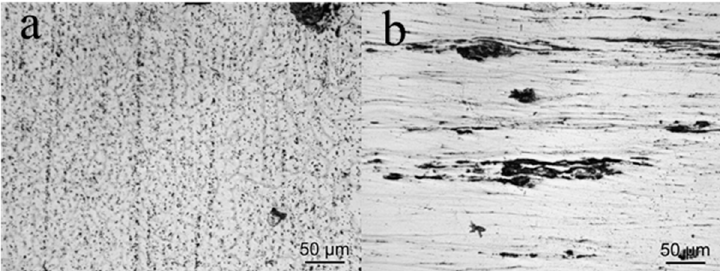
Figure 2. Microstructures of the wires at different stages of the manufacturing process: ( a ) Al–1 wt % Mg ingot treated with 1 wt % of NbB 2 nanoparticles; ( b ) final sample with Al–1 wt % Mg–1 wt % NbB 2 and 1 mm diameter.